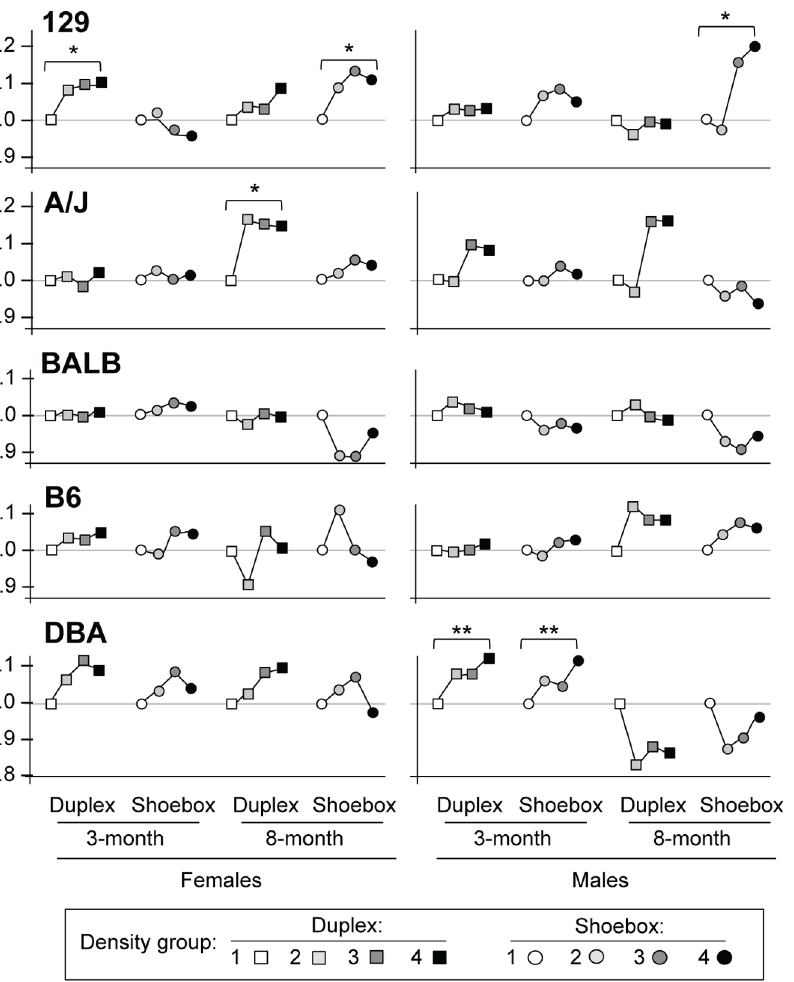
Figure 5. Percent fat. N=16–18 animals per sex/strain. The lowest density is given a value of 1.0 and all other densities are relative to that. Mean values and SEM are shown in Tables S2 and S3). P -values are comparisons of Density group 1 vs. Density group 4 only: * P , 0.05; ** P , 0.01; *** P , 0.005.